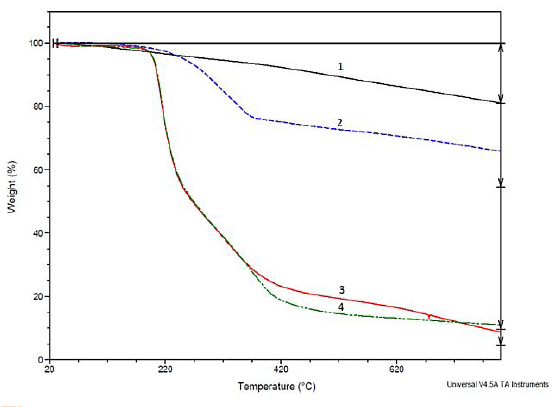
Figure 4. TGA curves of 1: MWCNT-COOH, 2-MWCNT-COOH- CDDP, 3-MWCNT-COOH-DOX, 4-MWCNT-COOH-CDDP-